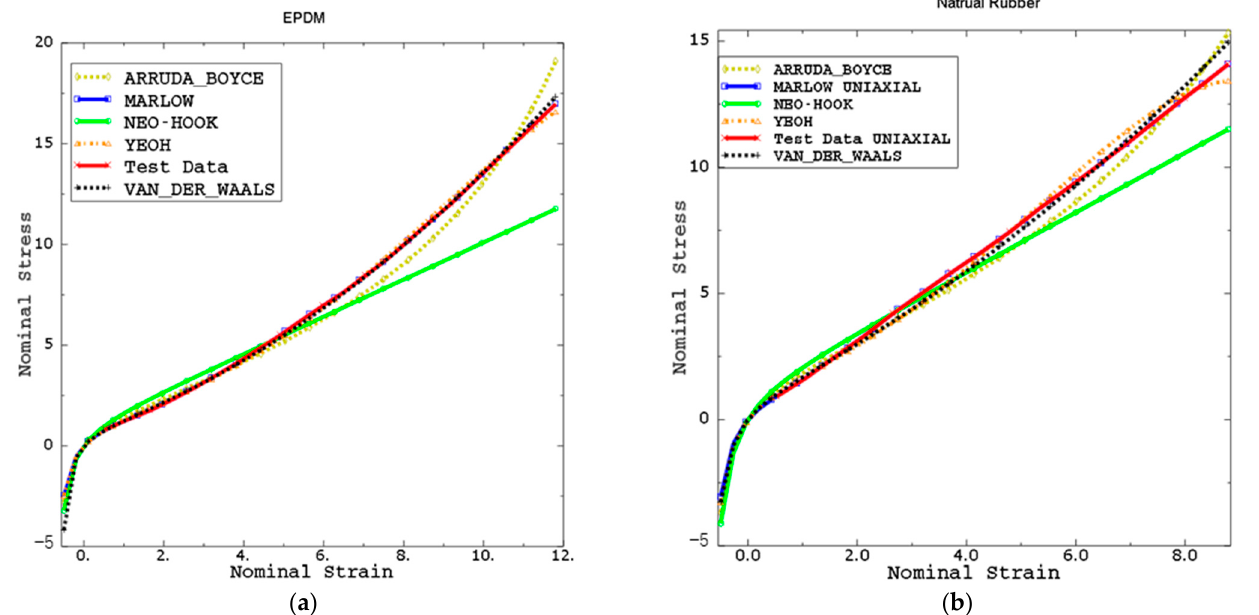
Figure 4. The results of the material model justification, from which one can see that the Yeoh model gives the best fit to the ( a ) EPDM and ( b ) NR.